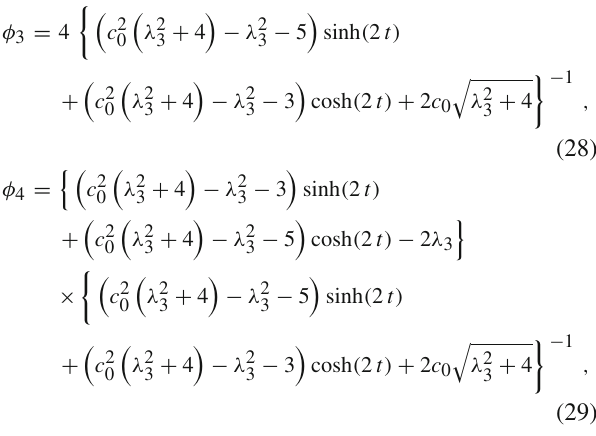
analytical solutions which satisfy Eqs. (26) and (27) have the forms